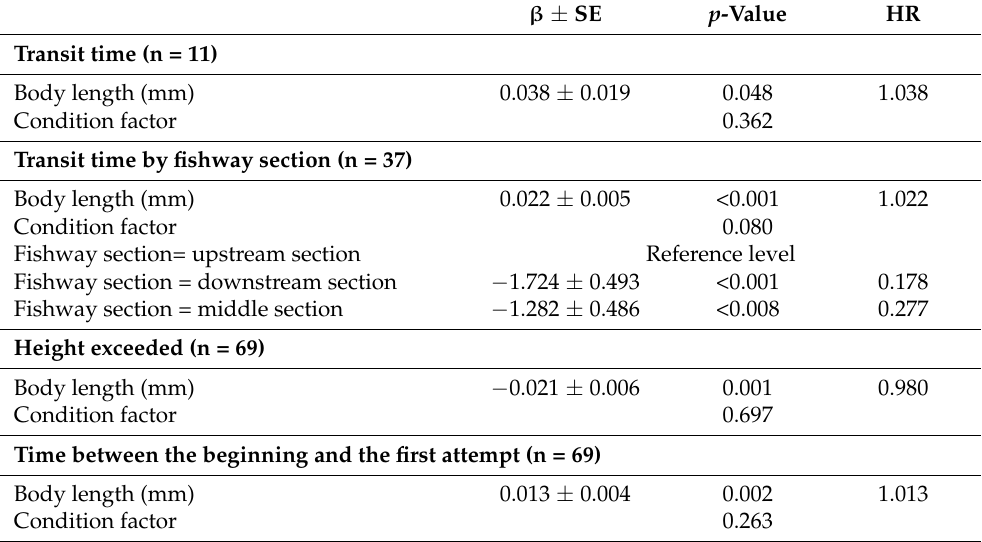
Figure 4. ( a ) Kaplan–Meier curves of the transit time (min/m) and ( b ) box-plot and diamond distribution of the passage success; data collected relative to brown trout passage in different pool-weir fishways based on [10] (VS: vertical slot; SNBO: submerged notch and bottom orifice; PN: plunging notch). The black solid line in ( a ) and the black dot in ( b ) represent the results of the present case study. Dashed lines represent studies with free trial conditions, whereas solid lines represent confined trial conditions. Table 3. Estimation of the parameters of the Cox Proportional Hazard models ( β : regression coeffi- cient; HR: Hazard Ratio = exp( β ); SE: Standard Error) for the response variables in relation to the body length (in mm), the condition factor, and the fishway section (the latter only for the evaluation of transit time by fishway